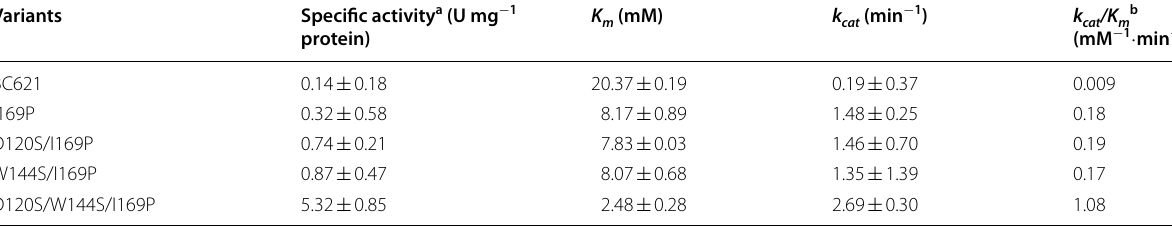
DAPDH: meso -diaminopimelate dehydrogenase a The specific activity was determined with 10-μM purified Cg DAPDH BC621 or its variants and 10-mM HPGA in 1-mL Tris–HCl buffer (50-mM, pH 8.0, 20-mM NH °C for 15 min